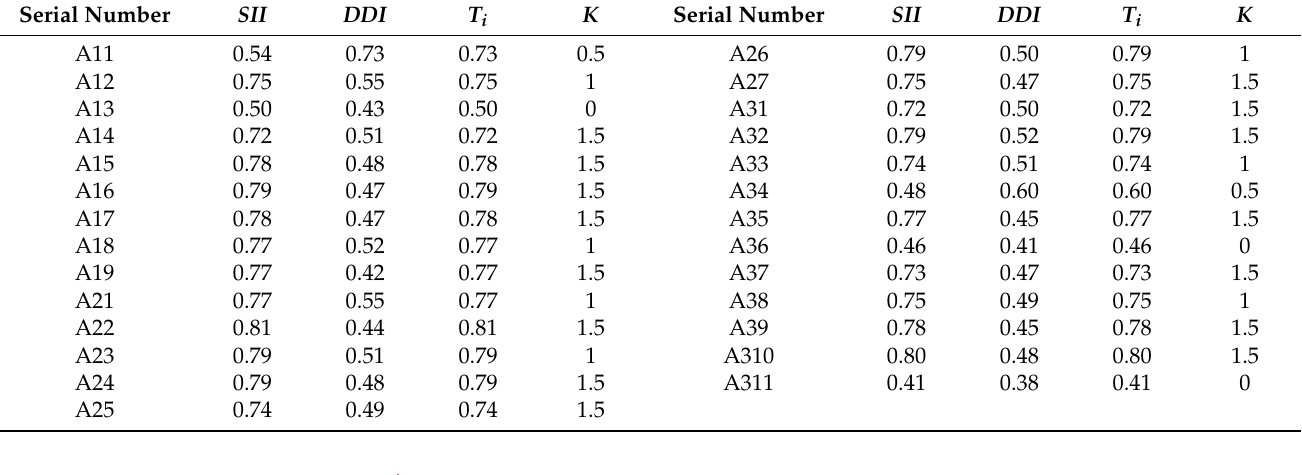
Table 5. Table of user satisfaction values and adjustment values.